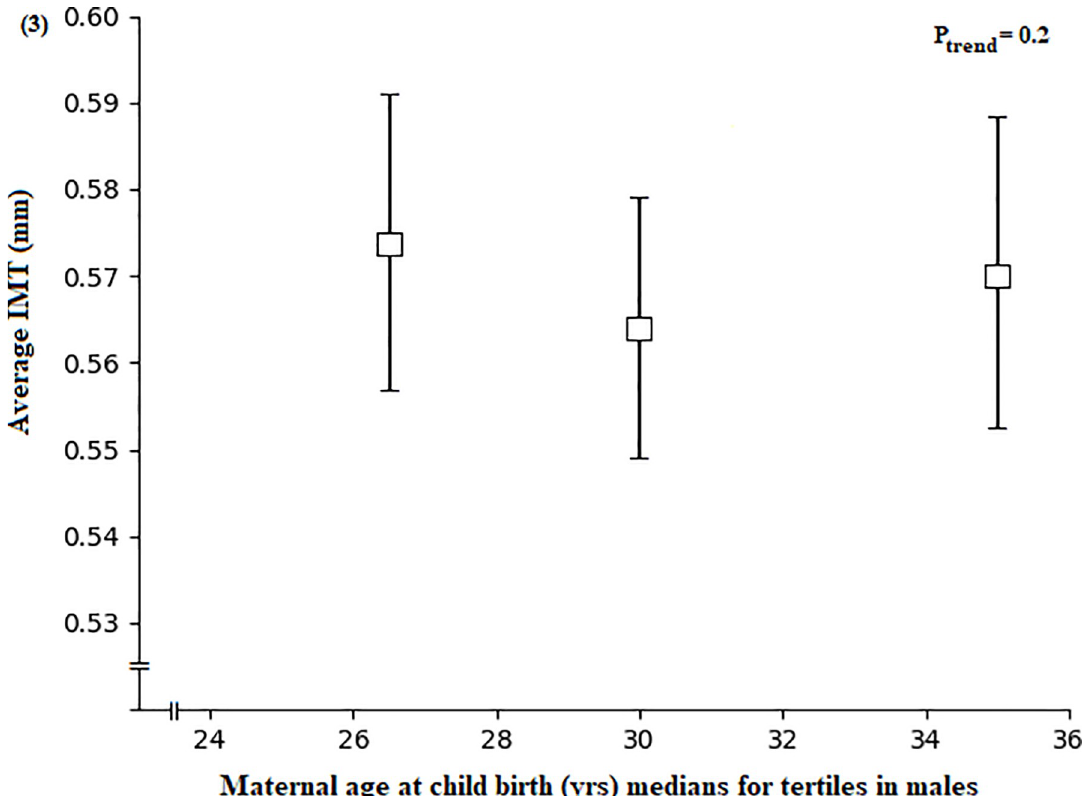
Fig 3. Association between maternal age at child birth and intima media thickness. Maternal age at child birth by tertiles of average IMT adjusted for age by the residual method in young adulthood among male participants. Data are means and 95% CI adjusted for adult age at IMT measurement, the physician taking the IMT measurement and birth year (residuals of birth year were calculated on age at IMT measurement), (n = 120).